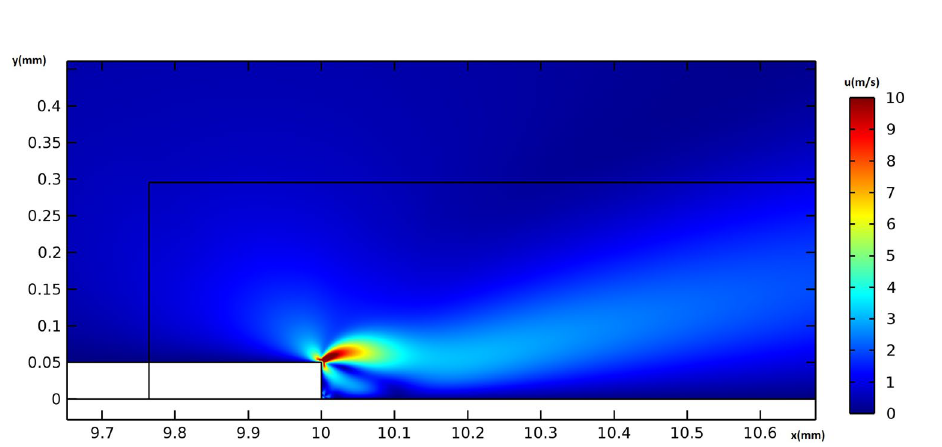
Figure 9. The flow velocity field around the actuator in ms − 1 , for the actuation case of V = 6 kVpp and f = 8